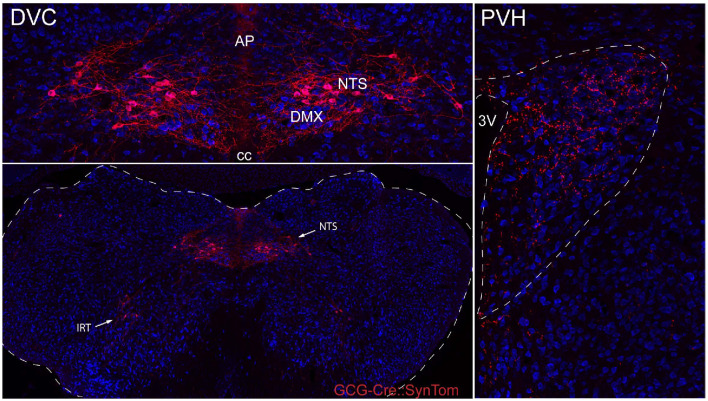
Distribution of GCG-Cre::SynTom expression in the hindbrain and hypothalamus.GCG-Cre mice were crossed with mice carrying a fluorescent reporter synaptophysin-tdTomato fusion protein to visualize PPG neurons and their inputs. Neurons expressing GCG-Cre::SynTom (PPG neurons) were detected primarily in the NTS, and a second small population of neurons was identified in the IRT. Dense GCG-Cre::SynTom-labeled inputs were observed in the PVH.